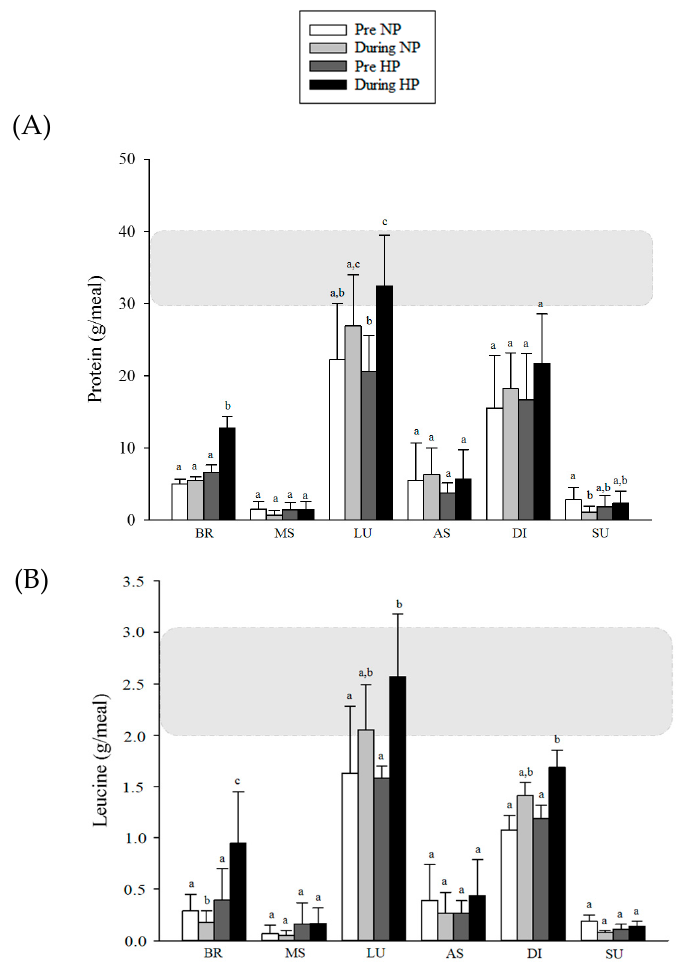
Figure 4. Distribution of protein ( A ) and leucine ( B ) according to meals of participants in the study. Notes: BR: breakfast; MS: morning snack; LU: lunch; AS: afternoon snack; DI: dinner; SU: supper. The darker rectangle in the graph represents the ideal amount that volunteers should achieve in consumption. Generalized Estimating Equation (GEE) with sequential Sidak post hoc. Different letters mean p < 0.05.